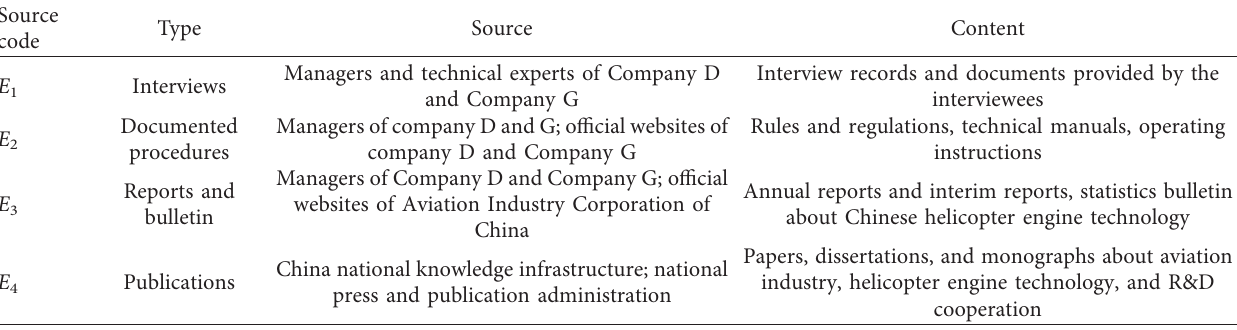
Table 3: Evidence sources and coding.